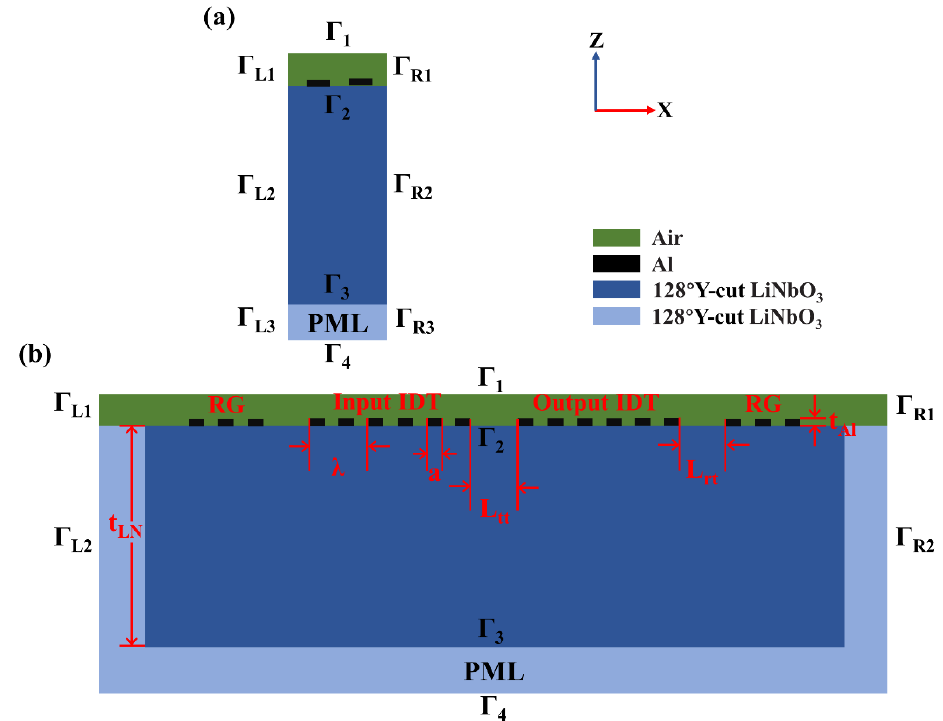
Figure 2. ( a ) The simplified 2D model with only one pair of electrodes ( Г i represents the boundaries). ( b ) The full-sized 2D model.